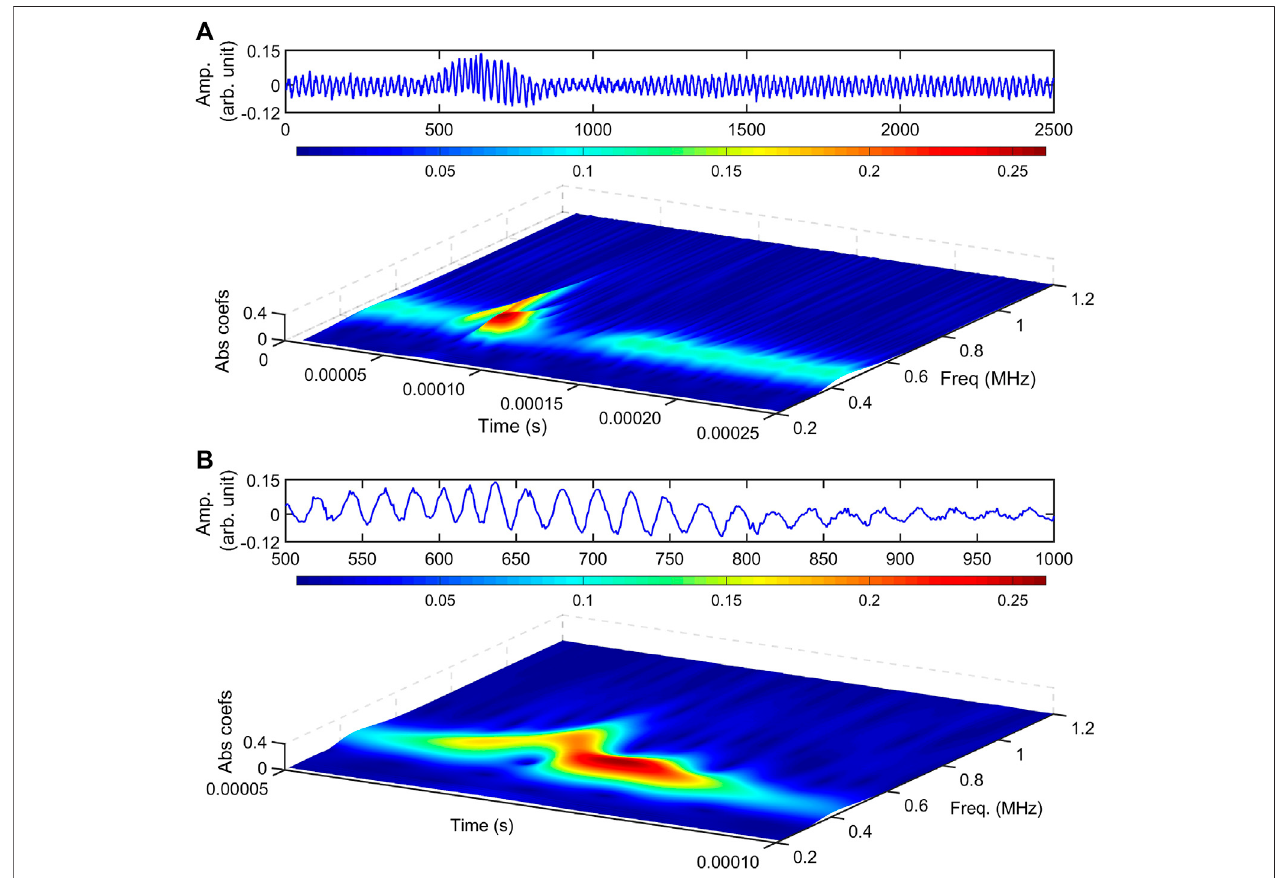
FIGURE 8 | Typical CWT scalogram of fundamental Peregrine soliton with the application of V HF (cid:2) 80 mV. The probe position is at 9 cm. (A) Time series (top) and CWT scalogram for data length 0 – 250 µs (bottom). (B) Enlarged view of (A) for data length 50 – 100 µs.